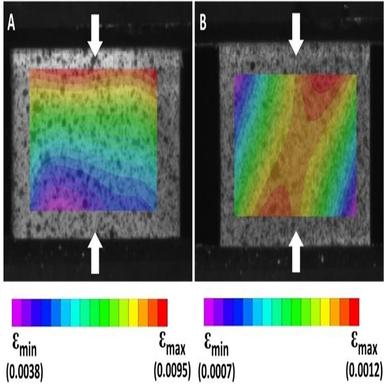
Typical DIC image compressive strain (ε) profiles during compression. (A) Type A configuration, (B) Type B configuration. White arrows show compressive load direction.